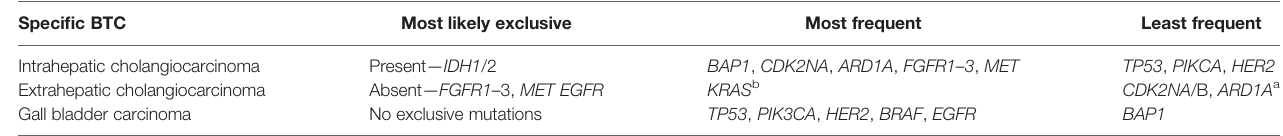
TABLE 1 | Prominent differences in mutated genes among the BTCs.